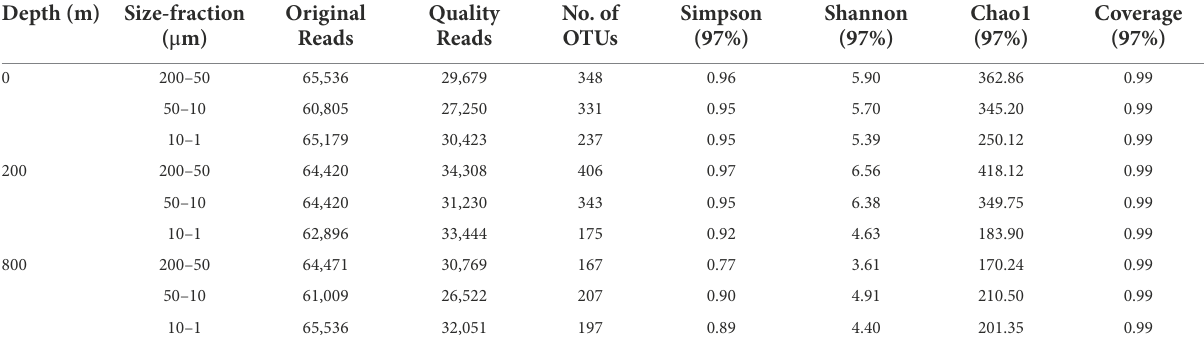
TABLE 1 Sequencing information and diversity parameters of the 16S rRNA gene in this study. Depth (m) Size-fraction Original Quality ( μ m) Reads